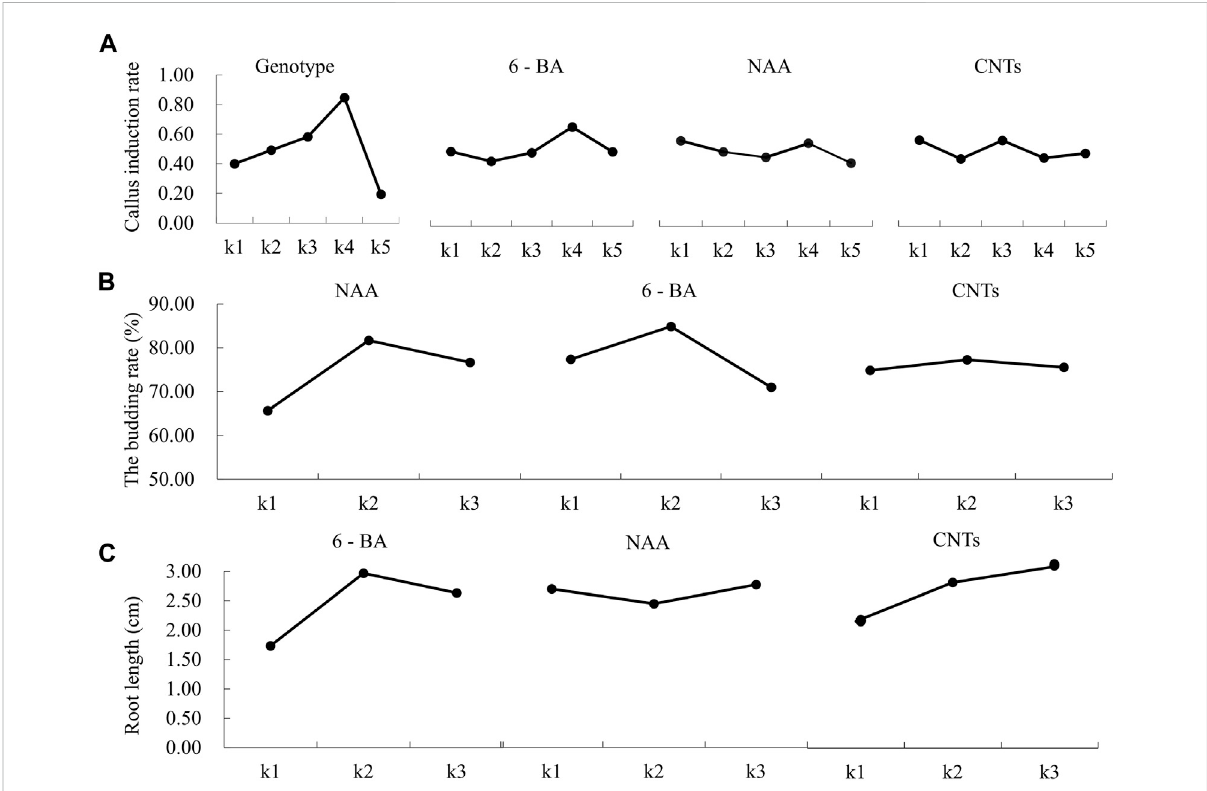
FIGURE 3 Effects of different factors on callus induction, germination, and rooting of hybrid seed embryos of calla lily. (A) Effects of different factors on callusinduction. (B) EffectsofdifferentconcentrationofNAA,6-BAandCNTsoncallusgermination. (C) EffectsofdifferentconcentrationofNAA,6- BA and CNTs on callus